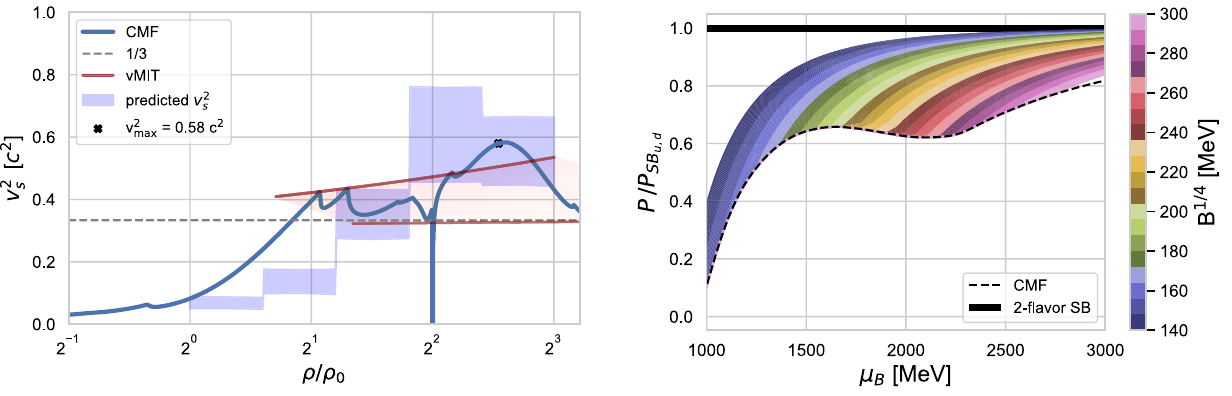
Fig. 1 Squared speed of sound v 2 s for CMF and both Bag models as Fig. 2 Pressure as function of baryon chemical potential. The colored function of density up to 8 ρ 0 in units of saturation density ρ 0 . Shaded areas are different Bag model EoS and the black dashed line is the CMF area is the estimated v 2 s (2 σ credible interval) from the deep neural EoS. A higher Bag constant shifts the Bag EoS to the right side and thus network. Solid blue: CMF model. A first order phase transition at 4 ρ 0 leads to a later phase transition. The horizontal black line is the Stefan is reflected in the squared speed of sound by the sudden drop to zero. Boltzmann At this density chiral symmetry is restored. The dashed grey line is the Stefan Boltzmann limit for an ultrarelativistic ideal fluid with squared sound speed v 2 s = 1 / 3. The squared speed of sound for the MIT Bag model is 1 / 3. The CMF model converges to this value at large densities ≥ 30 ρ ∼ 8 ρ/ρ B (not shown here). The black cross at 0 is the maximum sound speed of the CMF EoS. This regime appears due to the strong repulsion among hadrons. Solid red: upper and lower limits for vMIT Bag model (using different repulsive couplings)